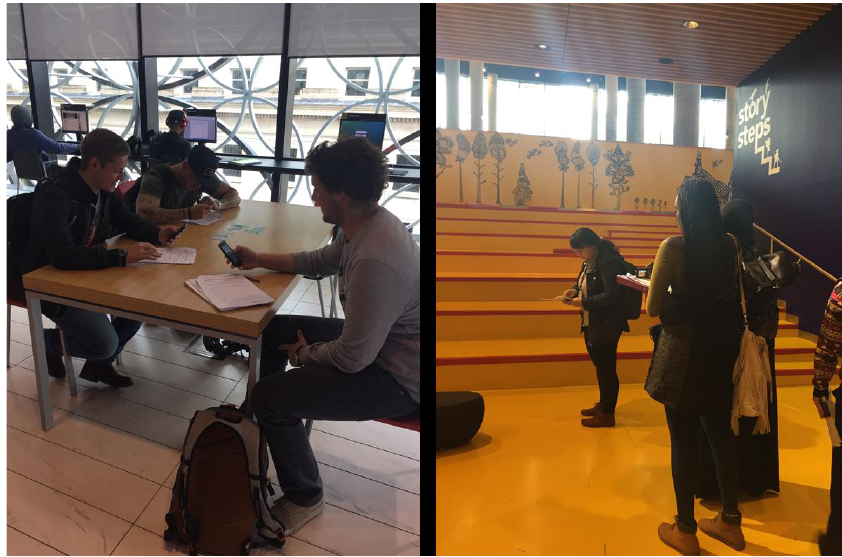
Figure 3: Group D soundwalk (left) and Group B soundwalk